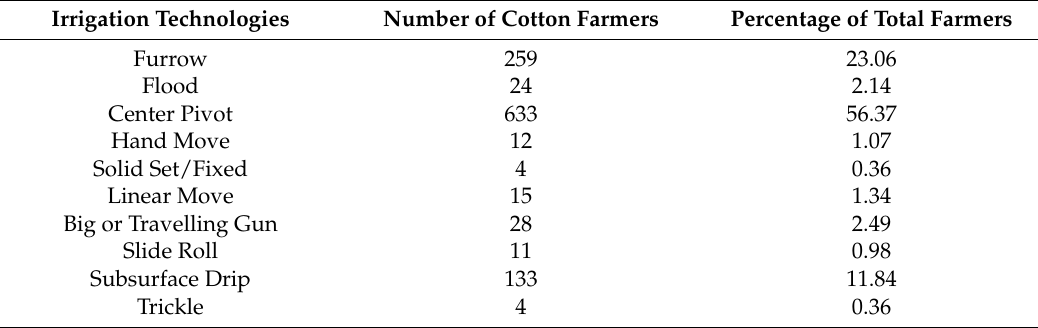
Table 1. Irrigation technology adopted by cotton farmers in the study region.